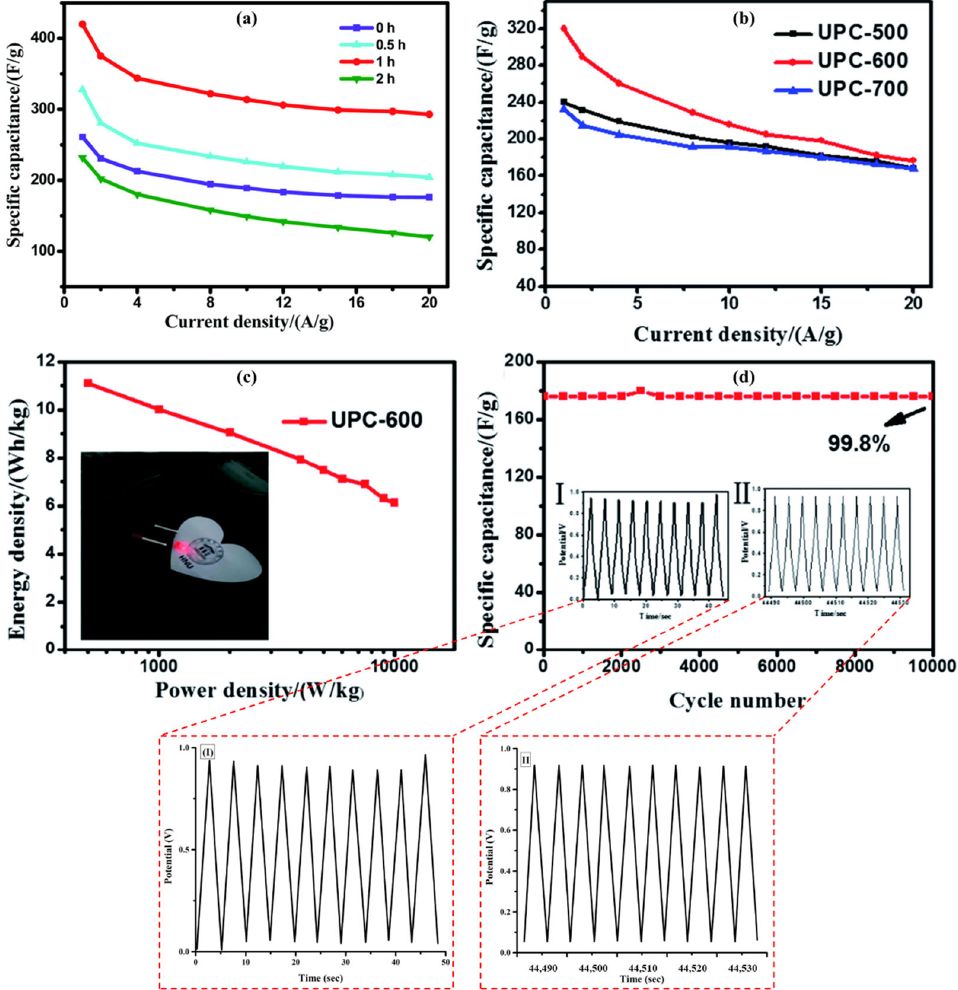
Figure 13. ( a ) Specific capacitance at current density ( b ) Specific capacitance at temperatures 500, 600 and 700 °C ( c ) Energy and power densities ( d ) 99.8% cyclic performance for 10,000 cycle numbers loaded at 20 A/g. The inset figure is the first 10 ( I ) and the last 10 times ( II ). Reprinted with permission from Ref. [219]. Copyright © (2020) The Royal Society of Chemistry.